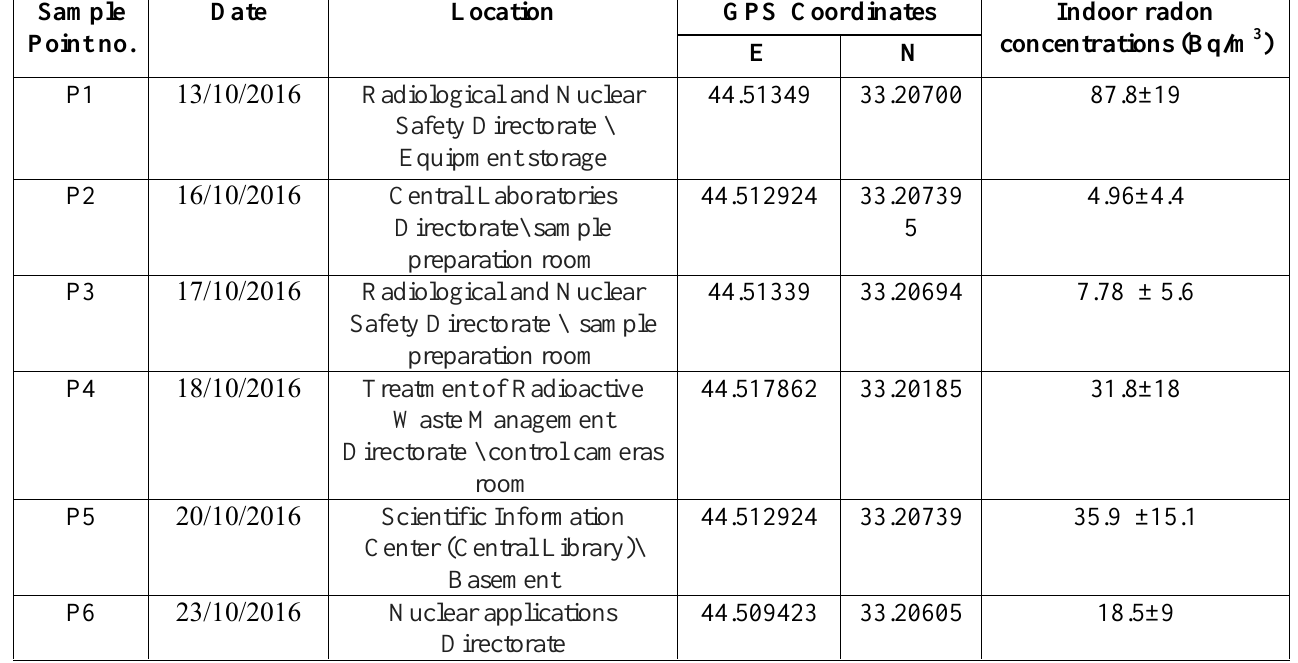
Table 1: Indoor radon concentrations in deferent